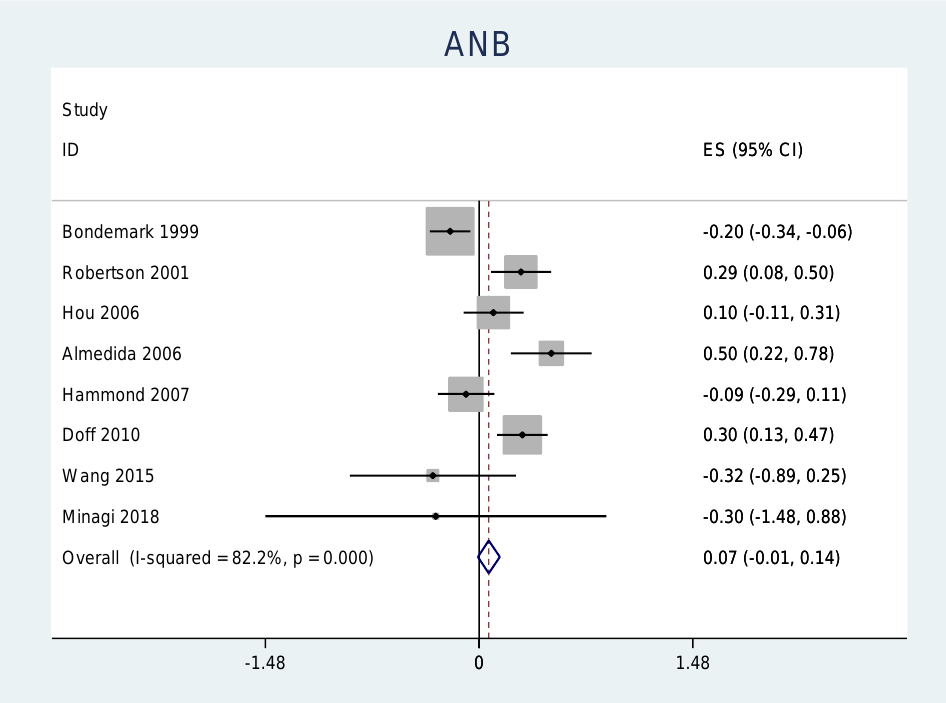
Figure 4. Forest plot of the results of ANB changes using the random-effects model.